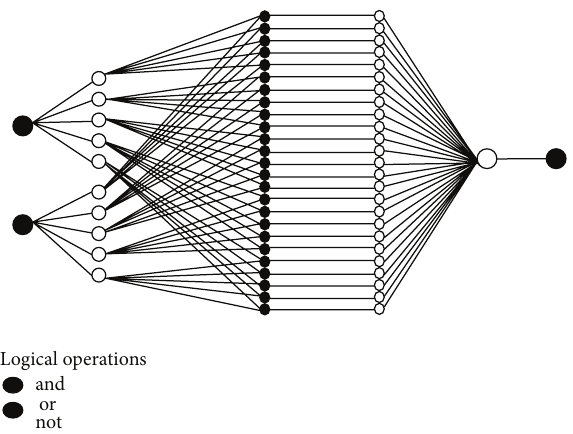
Figure 5: Detailed fuzzy rules model (inputs, membership func- tions, rules, and